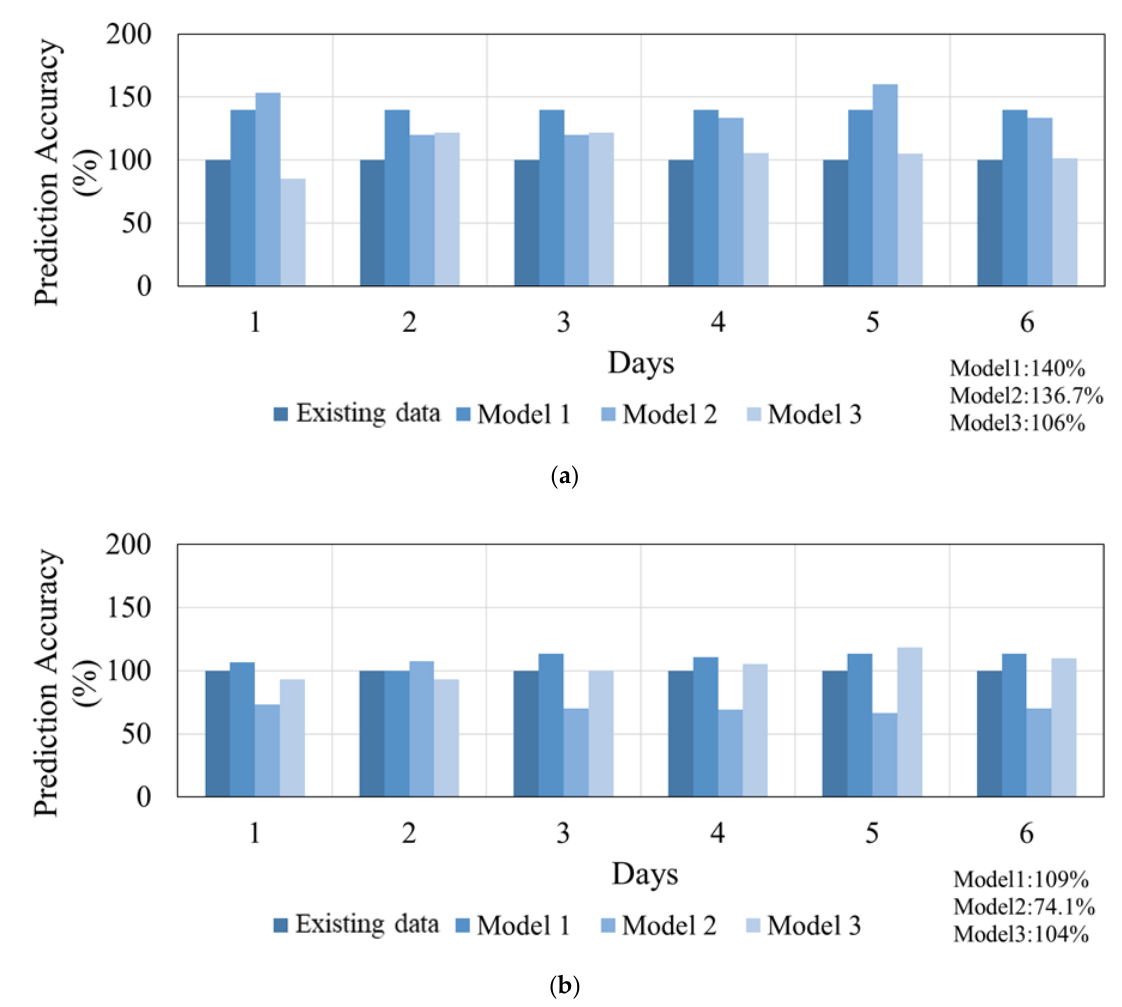
Figure 5. Prediction accuracy from outdoor units using existing data. ( a ) Comparison of prediction accuracy in summer; ( b ) comparison of prediction accuracy in winter.